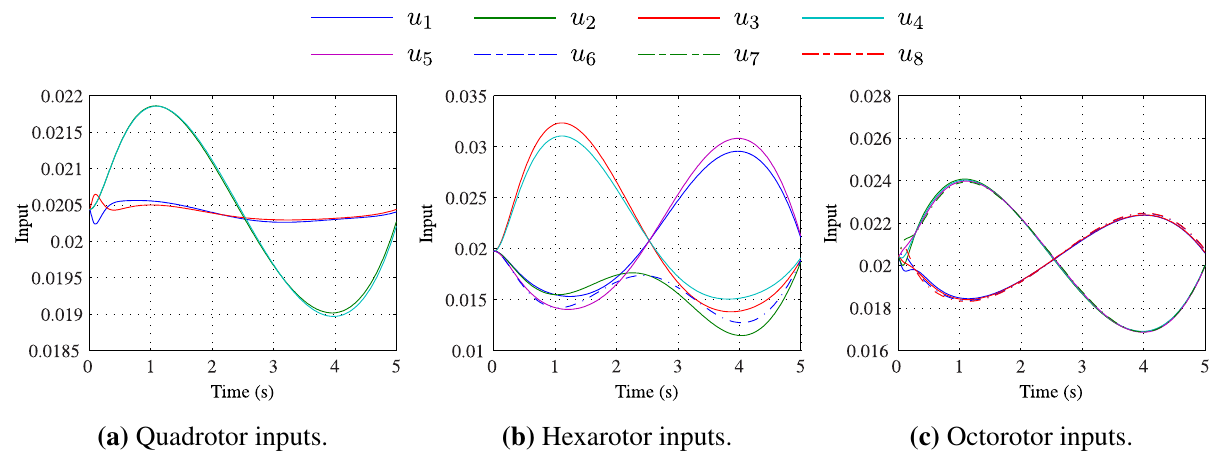
Figure 8. Motor input histories for each configuration while tracking a flight path with equivalent accuracy.